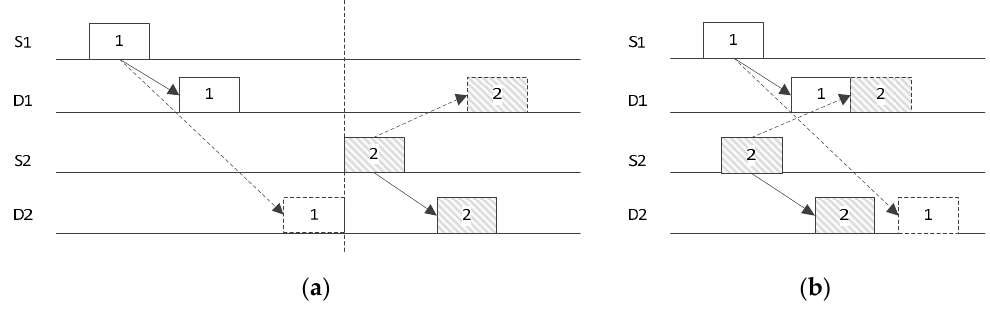
Figure 1. Serial transmission and time domain parallel transmission. ( a ) serial transmission; ( b ) time domain parallel transmission.